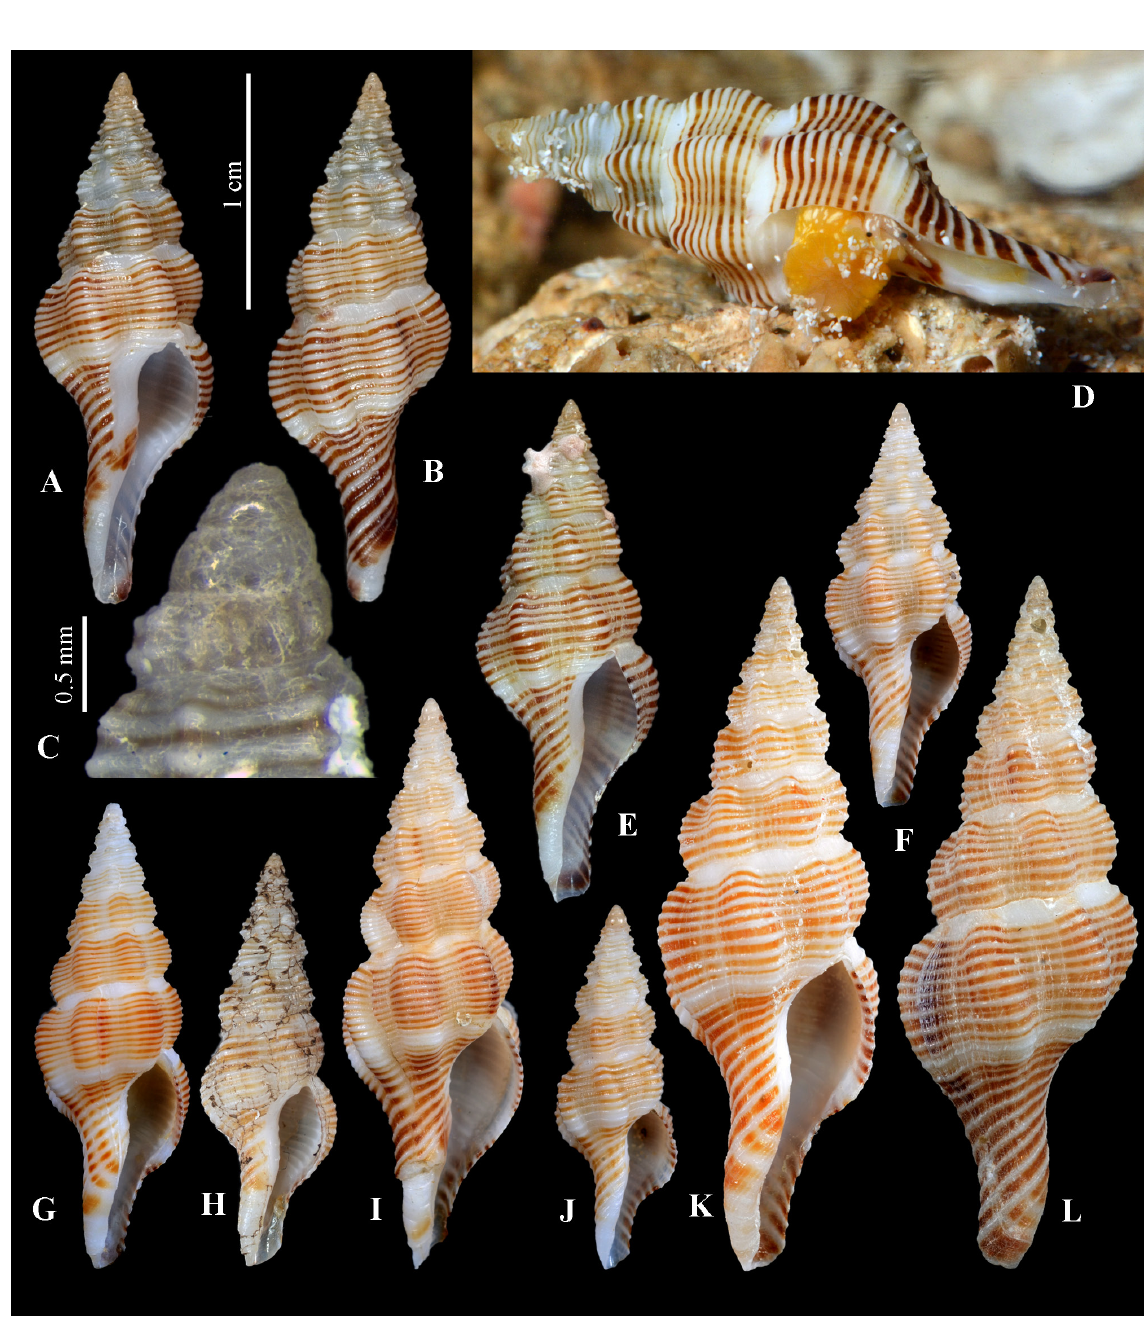
Fig. 10. Okutanius ellenae gen. et sp. nov. A–D . Holotype , New Caledonia, South of Ile des Pins, 22°53′ S, 167°35′ E, 376–390 m, SL 22.7 mm, sequenced specimen (MNHN IM-2013-68819). E . Paratype from the type locality, SL 21.4 mm, sequenced specimen (MNHN IM-2013-68876). F . New Caledonia, SMIB 5, s tn DW98, 23°02′ S, 168°16′ E, 335 m, SL 17.3 mm. G . New Caledonia, BATHUS 3: stn CP804, 23°41′ S, 168°00′ E, 244–278 m, SL 20 mm. H . New Caledonia, NORFOLK 1, stn DW1658, 23°26′ S, 167°50′ E, 320–336 m, SL 17.8 mm, radula, see Fig. 4H. I . New Caledonia, CHALCAL 2, stn DW79, 23°41′ S, 168°00′ E, 243 m, SL 24.4 mm. J . New Caledonia, SMIB 5, stn DW98, 23°02′ S, 168°16′ E, 335 m, SL 15.5 mm. K–L . New Caledonia, BATHUS 2, stn DW731, 22°49′ S, 166°45′ E, 300–370 m, SL 29.6 mm. All shells at the same